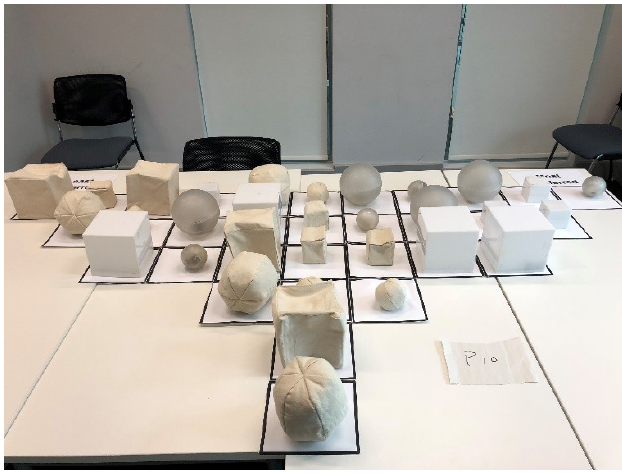
Figure 4. Example of Q-sorting result.